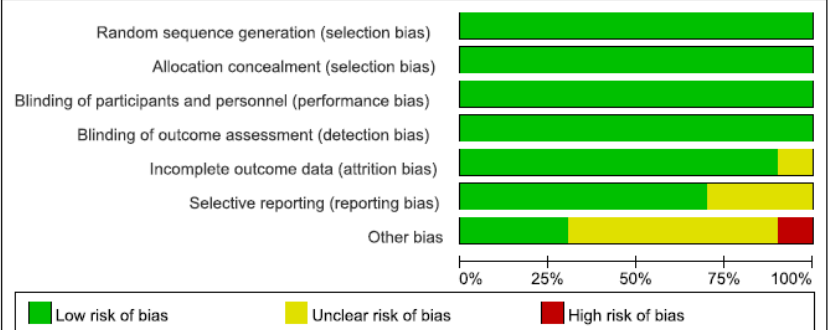
Figure 2. Risk of bias: a summary table for each risk of bias item for each study.